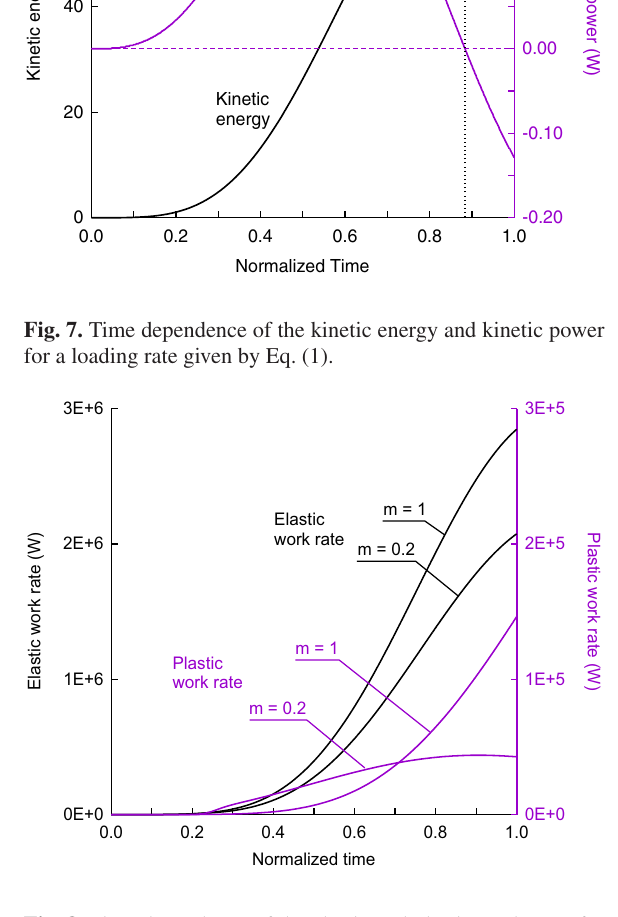
Fig. 8. Time dependence of the elastic and plastic work rates for elastic-viscoplastic materials with m = 0 . 2 and m =